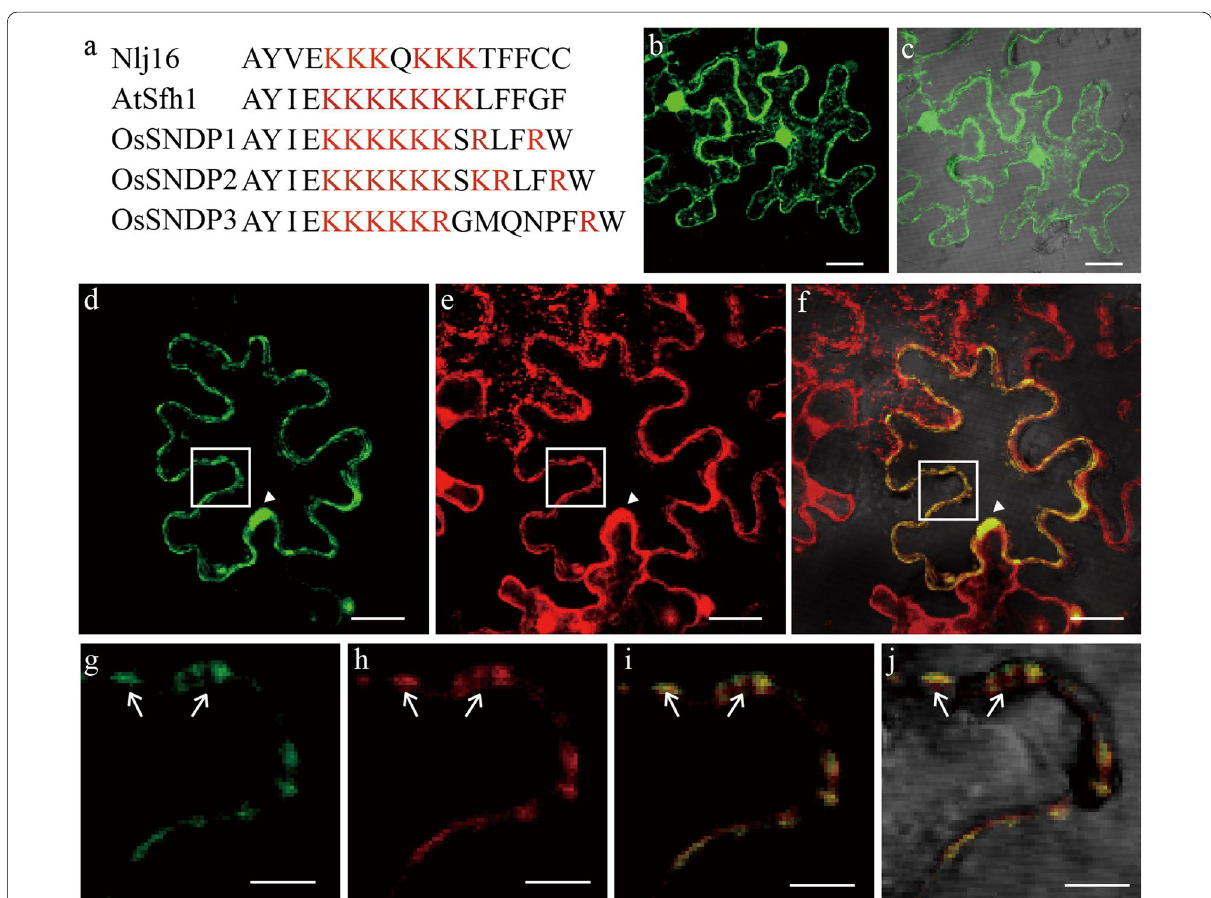
Fig. 2 Subcellular localization of OsSNDP3. a Alignments of the C‑termini of Class I nodulin domains protein. Basic amino acids are represented as red. Cells expressing 35S::GFP as control ( b and c ). Plasma membrane and nucleus (triangle) localization of GFP–OsSNDP3 ( d ), RFP–2X PH domain of PLCδ1 ( e ), and merged image ( f ). Highly magnified image ( g – j ). Arrow indicated microdomains of the plasma membrane. GFP and RFP signals appeared as green and red. Bars 20 µm ( b – f ) and 5 µm ( g – j =